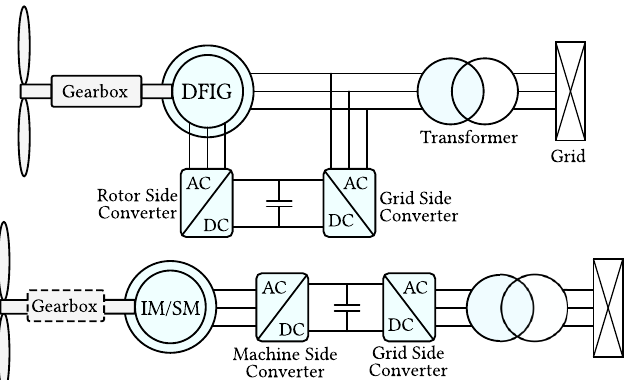
Figure 9. Typical architectures of Variable-Speed Wind Turbines. Top: Type 3, variable-speed with multiple-stage gearbox, DFIG and partial-scale converter. Bottom: Type 4, variable-speed with optional direct drive, IM or SM, and full-scale converter.